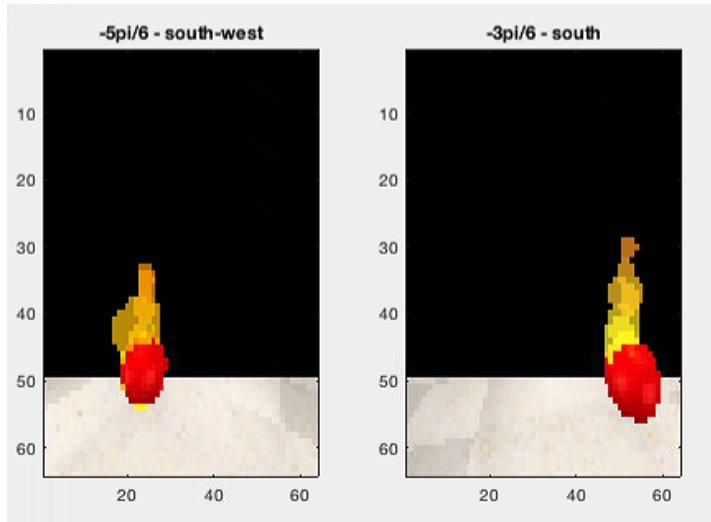
Figure 18. Fire-spot—hexagon 14 of Scenario